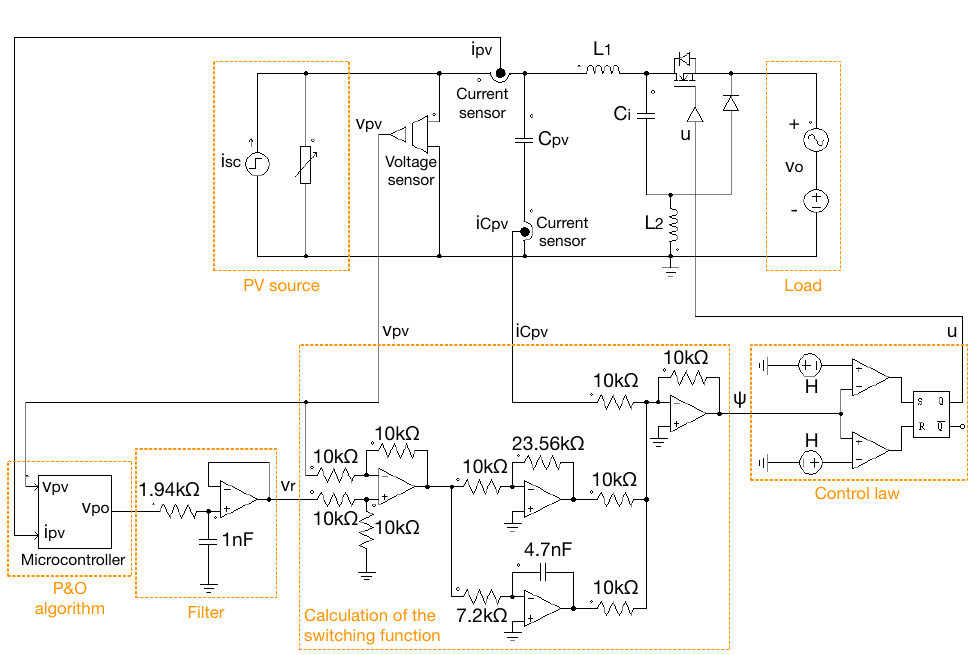
Figure 11. Circuital implementation of the PV system based on the CIOC converter and